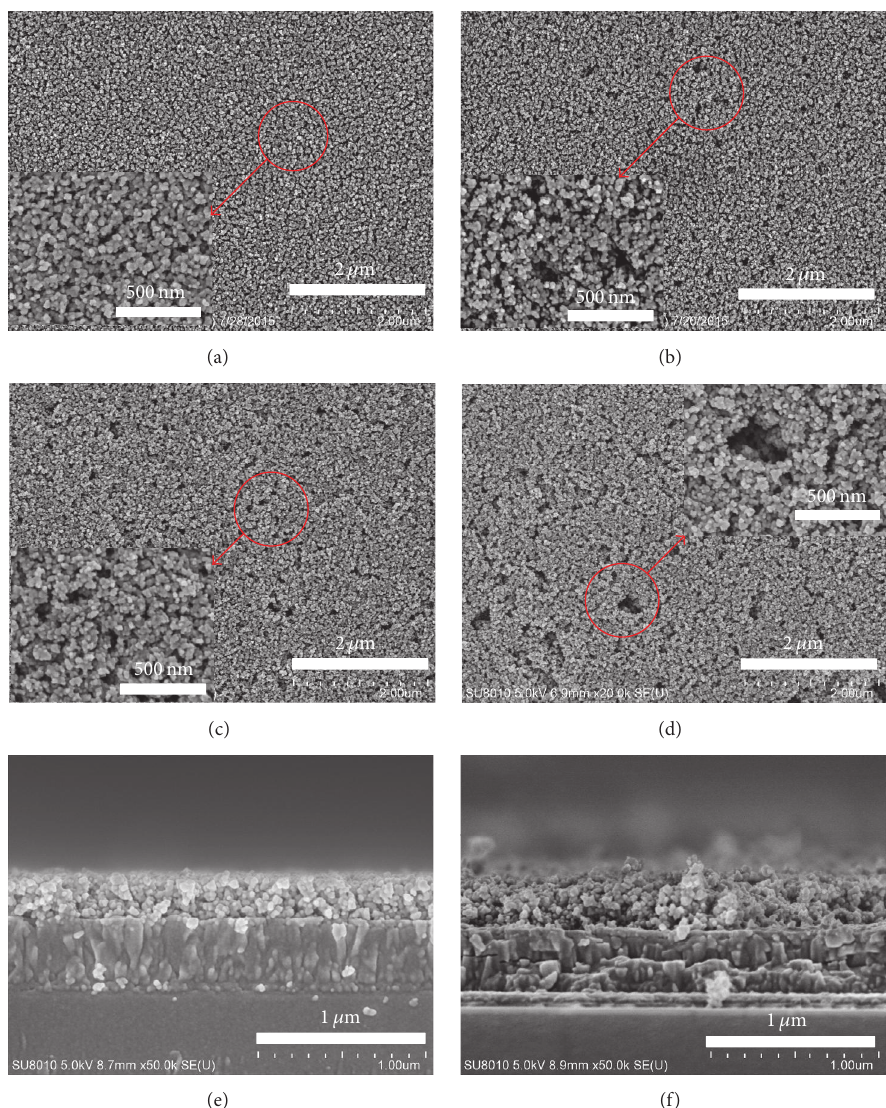
Figure 2: Plane-view SEM images of (a) PS-0, (b) PS-0.5, (c) PS-1.0, and (d) PS-1.5. Cross-sectional SEM images under high magnification of (e) PS-0 and (f)